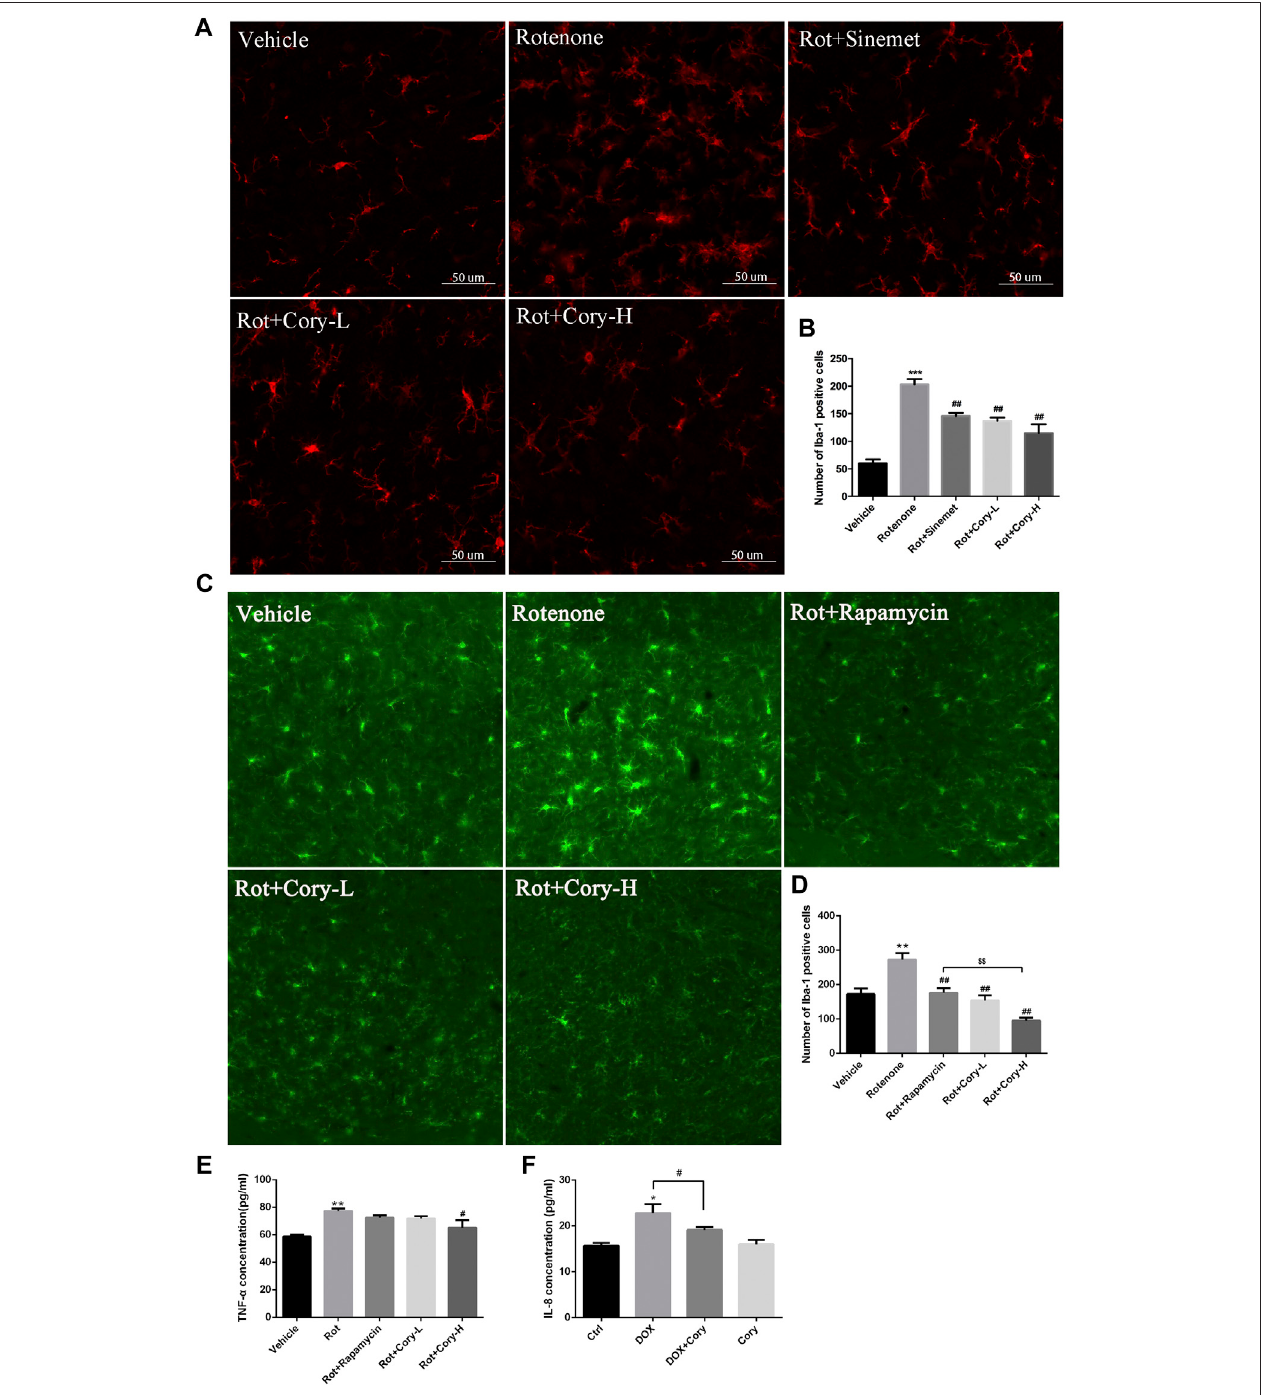
FIGURE5| Corydecreasestheneuroin fl ammation via inhibitingtheactivationofmicrogliaanddecreasingTNF- α .Corysigni fi cantlydecreasesthenumberofactive microglia cells both in the right-side SNpc of the PD rat model (A, B) and in the SNpc of the PD mice model (C, D) . (E) In the rotenone-induced mice model of PD, Cory signi fi cantly decreases the level of TNF- α in the serum. (F) Cory diminishes the release of IL-8 in inducible PC12 with overexpression of mutant α -synuclein (A53T). InduciblePC12cellsweretreatedwithdoxycycline for24 handfurthertreatedwithCory(25 μ M)foranother24 h.Supernatantwascollected,andthelevelofIL-8 was analyzed by ELISA. Dosage of Cory in the rotenone-induced rat model of PD: Cory-L: 2.5 mg/kg, Cory-H: 5 mg/kg. Dosage of Cory in the rotenone-induced mice model of PD: Cory-L: 5 mg/kg, Cory-H: 10 mg/kg. Data were presented as mean ± SEM. (** p < 0.01, *** p < 0.001 compared with Sham or Vehicle group; # p < 0.05, ## p < 0.01comparedwithRotenonegroup; $$ p < 0.01,Rot+Rapamycin v . s . Rot+Cory-H; * p < 0.05compared withCtrl, # p < 0.05comparedwithDox; n ≥ 6,one-way ANOVA with Newman – Keuls ’ multiple